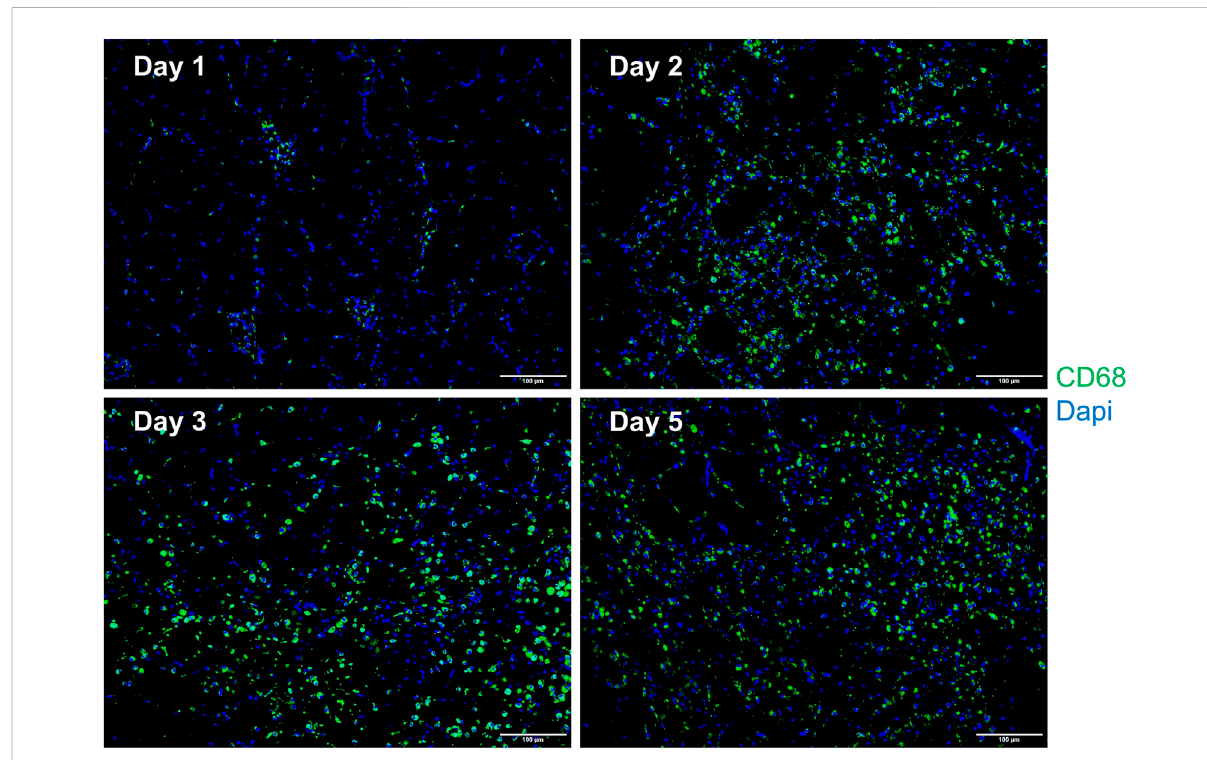
FIGURE 8 Representative merged macrophage IF images of the gastrocnemius at different times after the injury ( n = 10). Blue dots represent the nuclei, and green dots represent the macrophages. Scale bar = 100 μ m. A small number of macrophages can be seen on the fi rst day. The macrophages increase on the second day, reach the peak on the third day, and the fi fth day is similar to the third day.